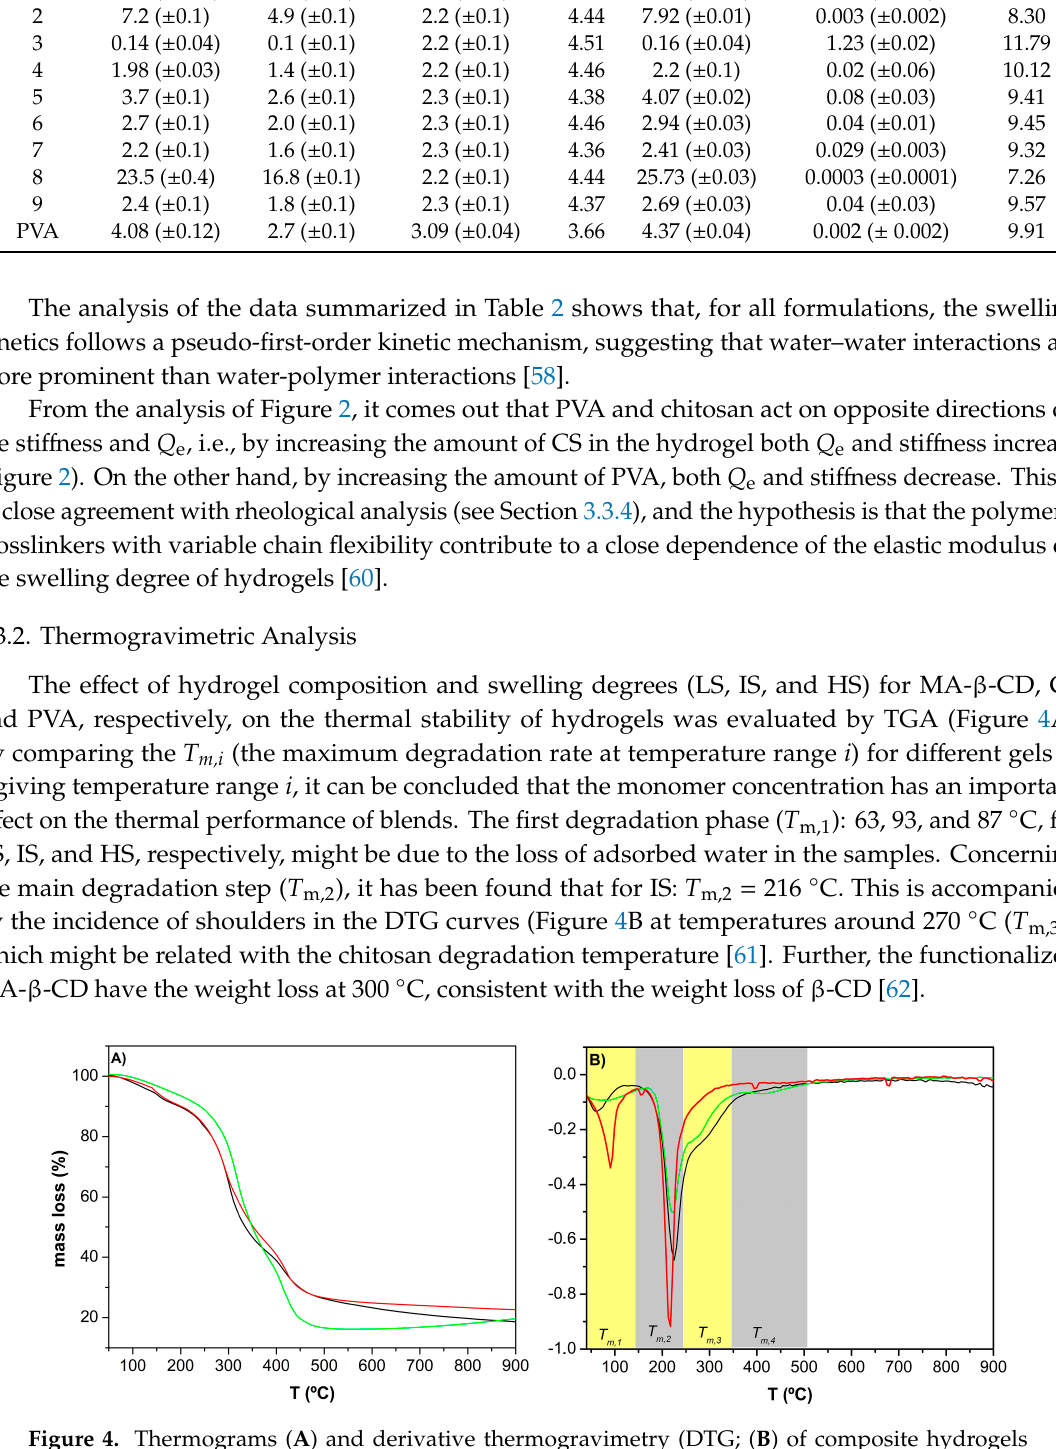
Figure 4. Thermograms ( A ) and derivative thermogravimetry (DTG; B ) of composite hydrogels based on PVA / CS / MA- β -CD, which presented a low ( ___ ), intermediate ( ___ ), and high ( ___ ) swelling degree,